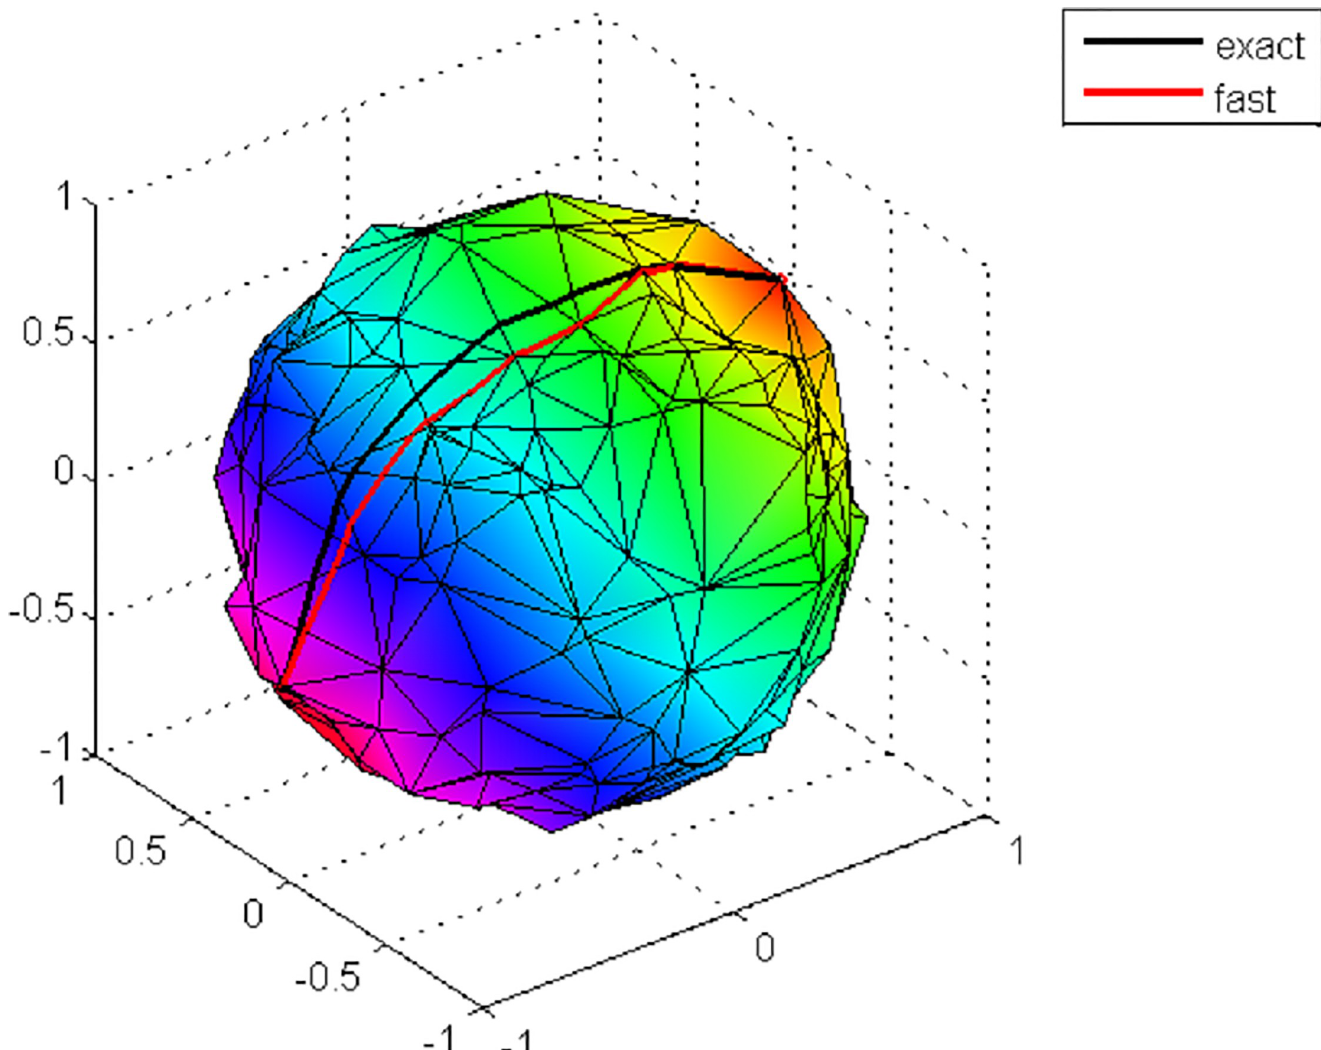
Fig 7. Exact versus fast marching algorithm. Extracting geodesic paths using an exact and a fast method for a synthetic mesh.